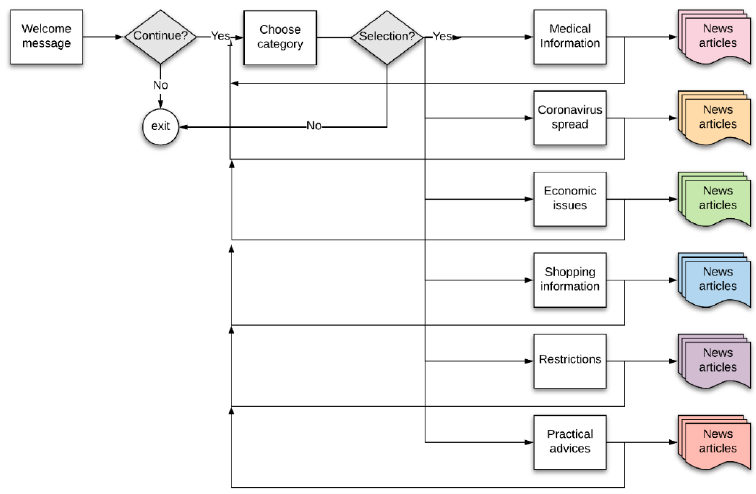
Figure 3. The flow diagram of the COVINFO Reporter chatbot.